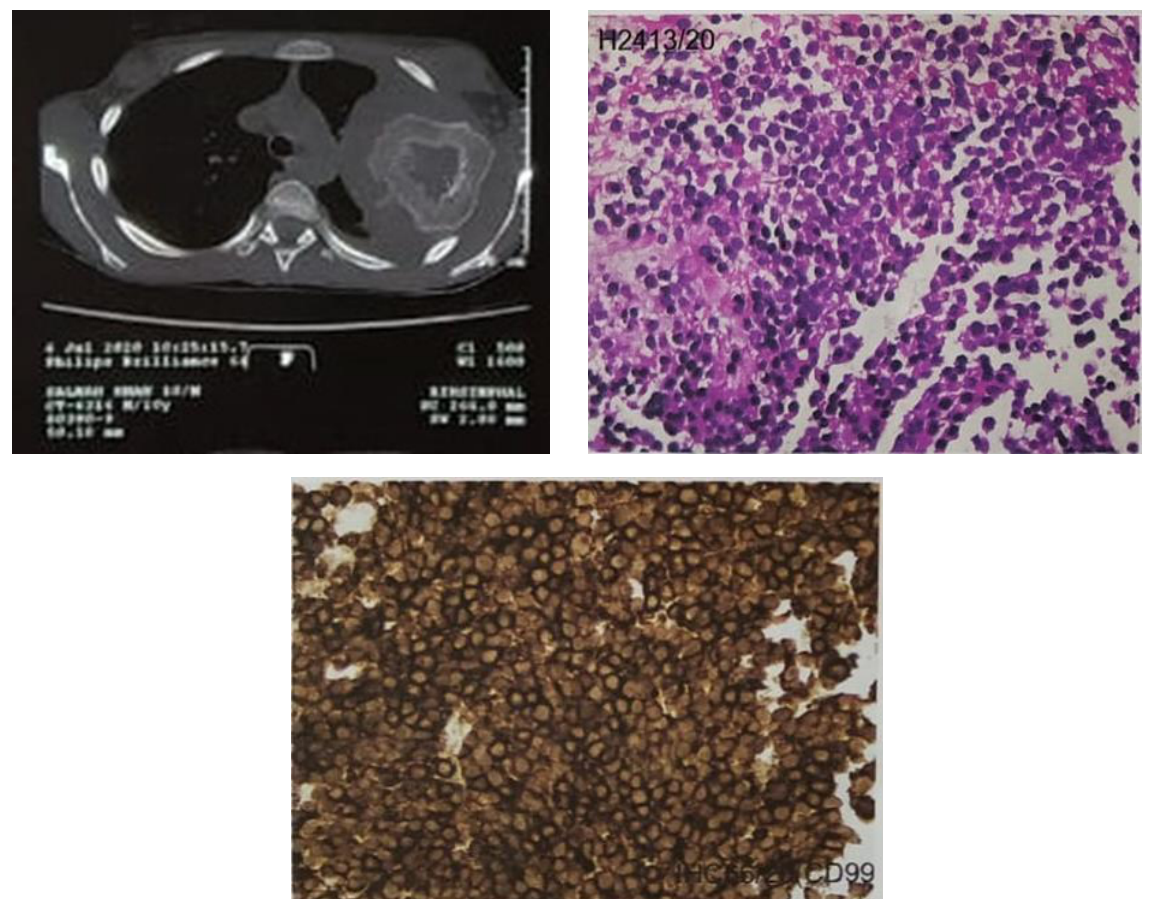
Fig. 1. Askin Tumor. (a) Swelling over left chest wall. (b) Massive pleural effusion. (c) HRCT thorax showing expansile lytic lesion with lobulated soft tissue component. (d) A small round cells malignant tumor with scanty cytoplasm and hyperchromatic nuclei arranged in sheets, clusters, and peritheliomatous patterns. (e) CD99/MIC-2